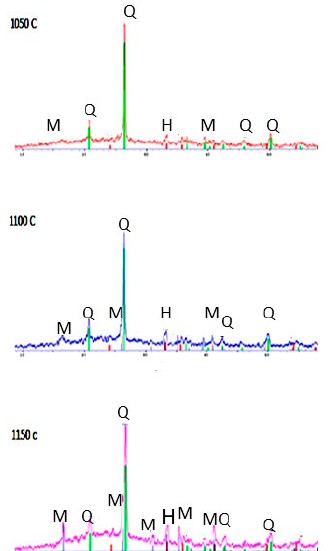
Figure 4. XRD diagrams of test bodies heated at different temperatures. Legend: Q: quartz; H: hematite; M: mullite.